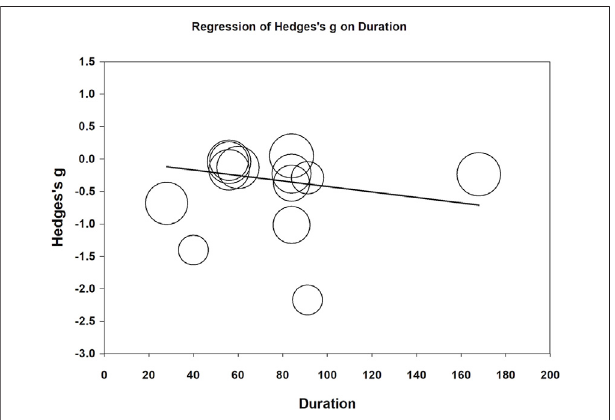
FIGURE 7 | Meta-regression of Hedges ’ g on daily dose (mg/day). The coef fi cient was -0.0017 with a p value < 0.001.